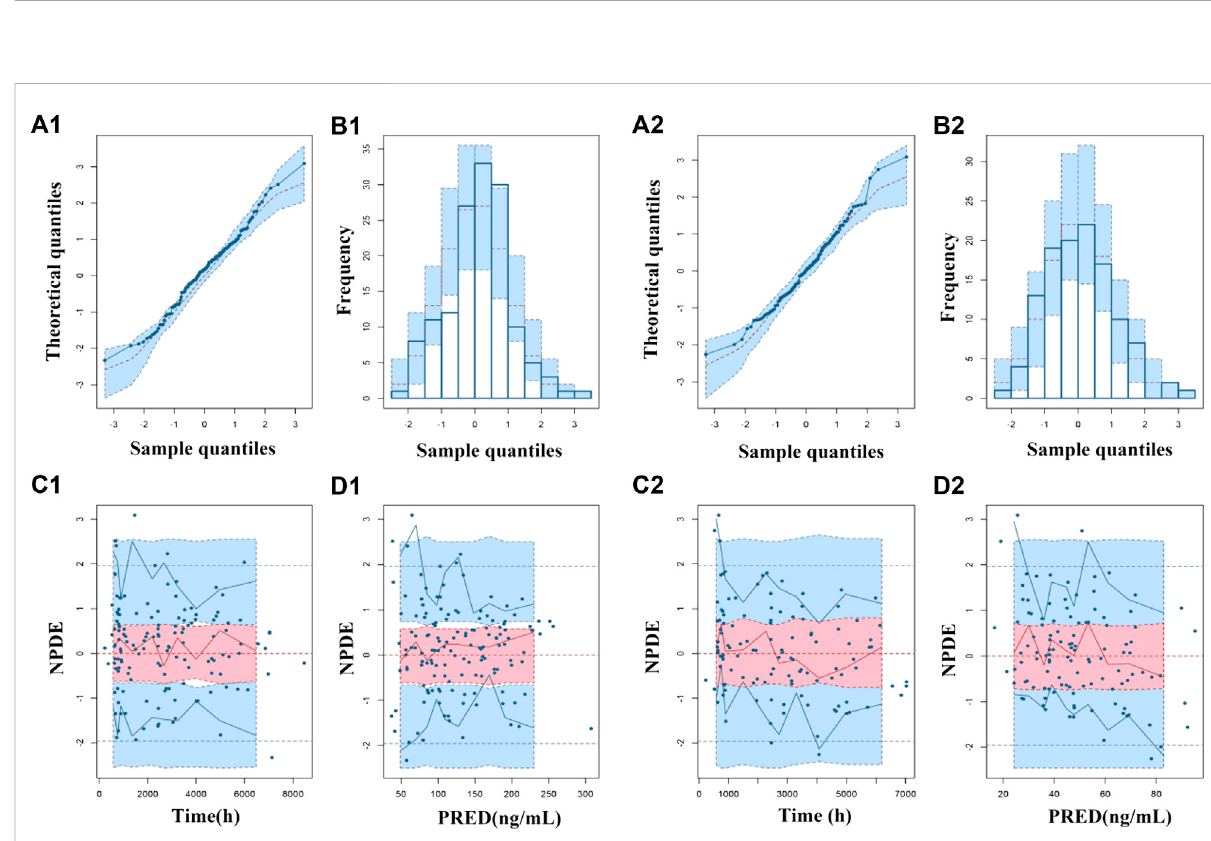
FIGURE 3 Normalized prediction distribution errors (NPDEs) of the fi nal population pharmacokinetic model for ARI (1) and DARI (2). (A1,A2) Quantile- quantile plot vs. the expected standard normal distribution for ARI and DARI; (B1,B2) Histogram of NPDE with the density of the standard normal distribution overlaid; (C1,C2) Scatterplot of NPDE against time; (D1,D2) Scatterplot of NPDE against